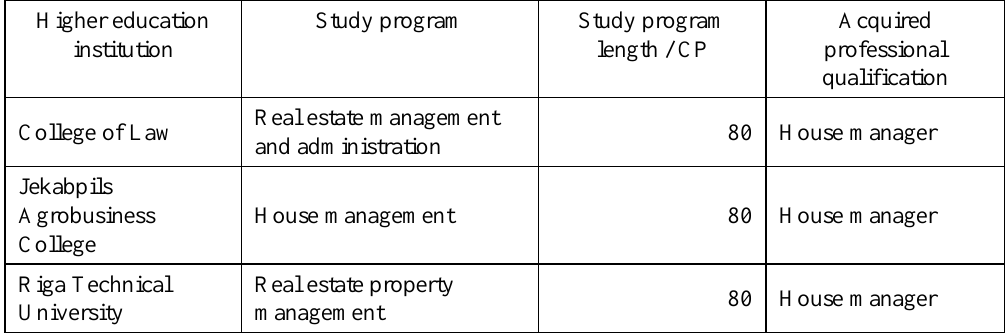
Table 1. Higher education institutions and study programs for the acquisition of